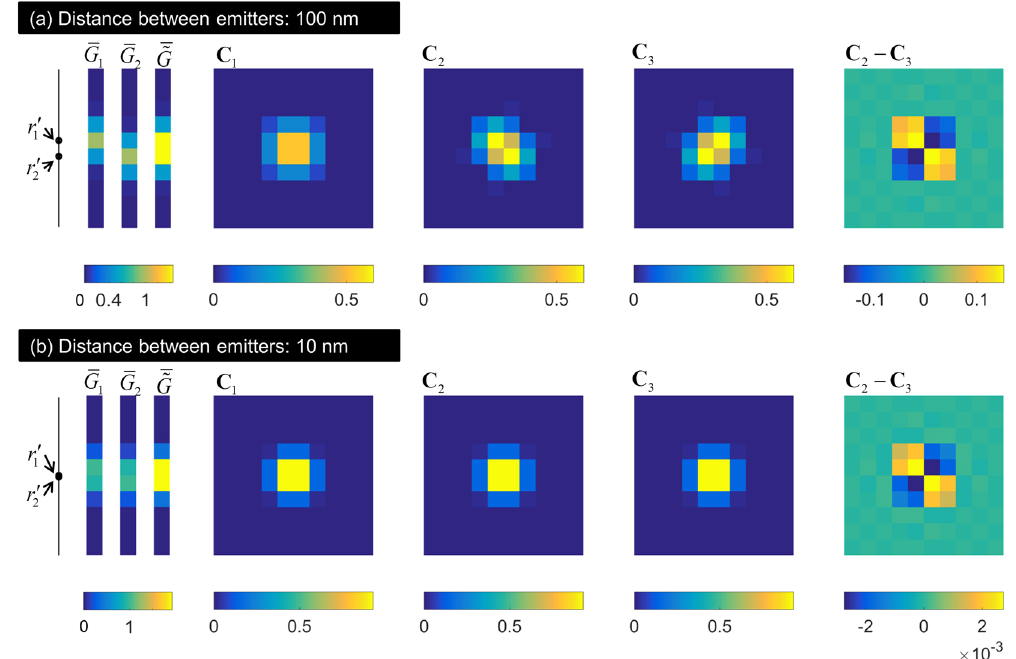
Figure 4. The effect of finite pixel size on the matrices C 1 , C 2 , C 3 , ( C 2 − C 3 ) is demonstrated here through Example 2. ( a , b ) correspond to distance between emitters being 100 nm and 10 nm, respectively. The pixel size is 100